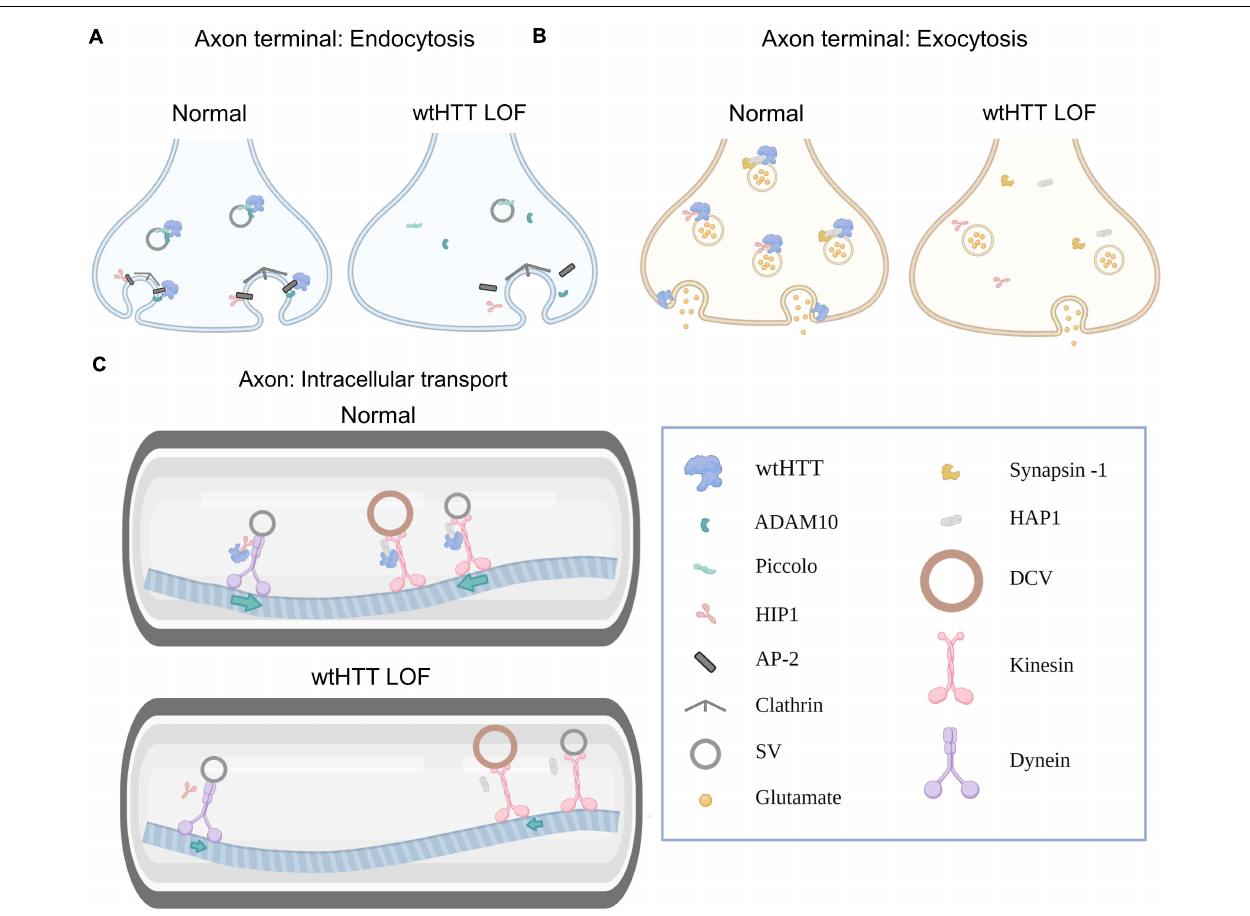
FIGURE 1 | Huntingtin and the presynapse. (A) Select examples demonstrating how wtHTT positively regulates endocytosis (left). Through associations with ADAM10 and piccolo, wtHTT regulates SV density at the readily releasable and reserve vesicle pools. Through associations with HIP1, AP-2 and ADAM10, wtHTT regulates clathrin-mediated endocytosis. wtHTT loss impairs endocytosis by disrupting the function of complexes with the aforementioned proteins (right). wtHTT LOF decreases SV density at the readily releasable and reserve vesicle pools and impairs clathrin-mediated endocytosis. (B) Select examples demonstrating how wtHTT positively regulates exocytosis. Through its associations with synapsin-1, HAP1 and HIP1, wtHTT can regulate the rate of SV exocytosis and the amount of neurotransmitter release. wtHTT loss disrupts exocytosis (right). (C) Select examples demonstrating how wtHTT positively regulates axonal transport (top). Through its associations with HAP1 and HIP1, as well as molecular motors, wtHTT maintains proper anterograde and retrograde transport of cellular cargoes including SVs and DCVs. wtHTT loss impairs axonal transport (bottom). Due to its associations with HAP1 and HIP1, as well as molecular motors, wtHTT loss interferes with anterograde and retrograde transport of cellular cargoes including SVs and DCVs. Abbreviations: LOF, loss of function; ADAM10, A disintegrin and metalloproteinase domain-containing protein 10; HIP1, huntingtin-interacting protein 1; AP-2, adaptor protein complex 2; SV, synaptic vesicle; HAP1, huntingtin-associated protein 1; DCV, dense-core vesicle. Figure created using